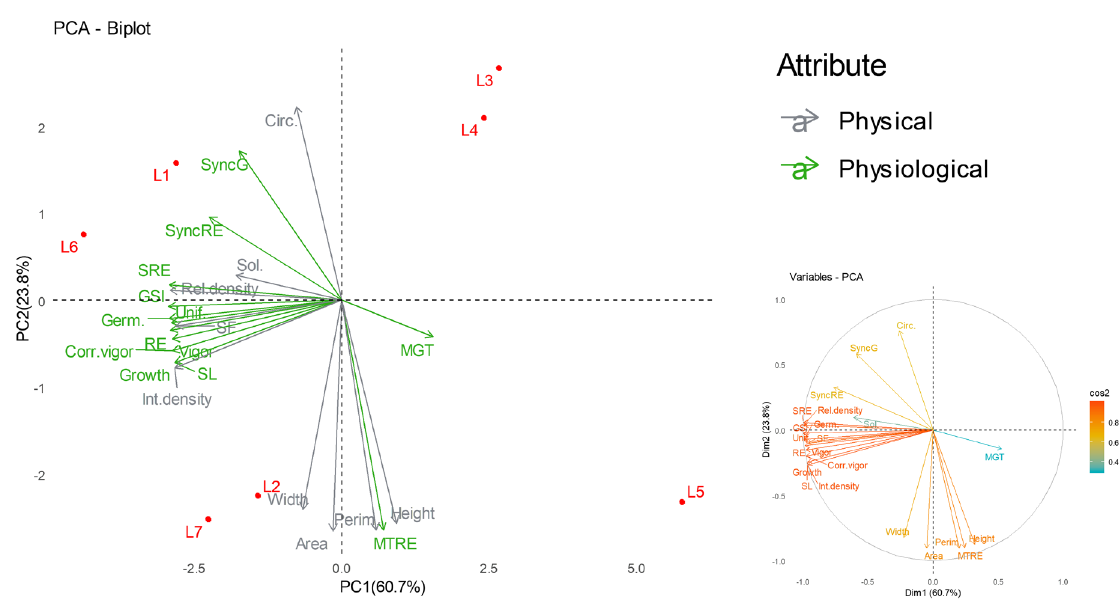
Figure 5. Biplot obtained by the linear combination of the variables related to the physical and physiological characteristics of seven lots of Brachiaria ruziziensis seeds. Germ. = Germination, RE = Radicle emergence, SRE = Speed of radicle emergence, GSI = Germination speed index, MTRE = Mean time for radicle emergence, MGT = Mean germination time, SyncRE = Synchrony of radicle emergence, SyncG = Synchrony of germination, SL = Seedling length, Unif. = Uniformity, Corr. Vigor = Corrected vigor, Perim. = Perimeter, Circ. = Circularity, Sol. = Solidity, Rel. density = Relative density, Int. density = Integrated density, SF = Seed